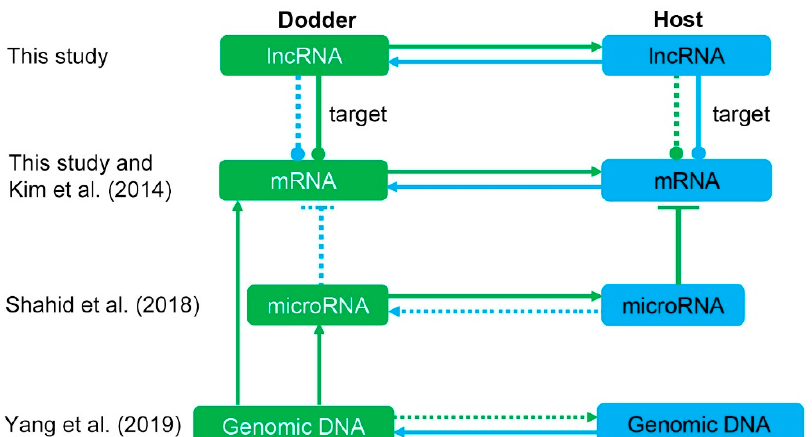
Figure 10. Mobile molecules in light of interaction with RNAs and DNA. Green represents parasite, blue represents host. Solid lines represent direct evidence, dashed lines represent potential pathways that currently lack evidence in this system. Kim et al. (2014), Shahid et al. (2018), and Yang et al. (2019) represent supporting references: [11], [13], and [46], respectively. Bidirectional transfer of lncRNAs was observed by RNA sequencing in this study, but the cross-species targeting of mobile lncRNAs to foreign genes requires further experimental validation.